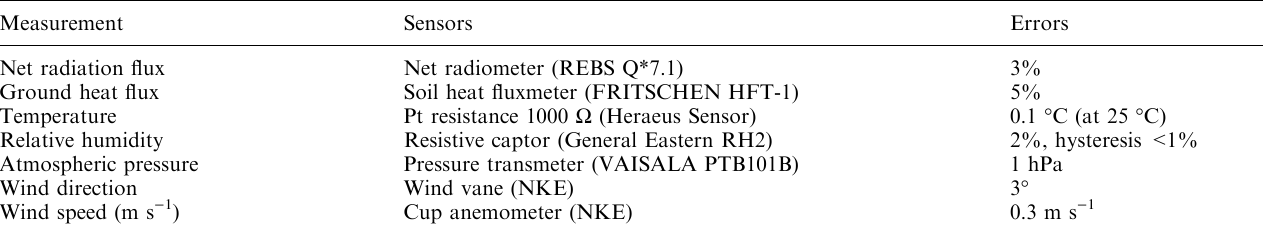
Table 3. Sensors used for the SBL study during the WELSONS experiment. Makes of sensors and errors for each sensor are also given. Temperature indicates soil as well as air temperature probes.